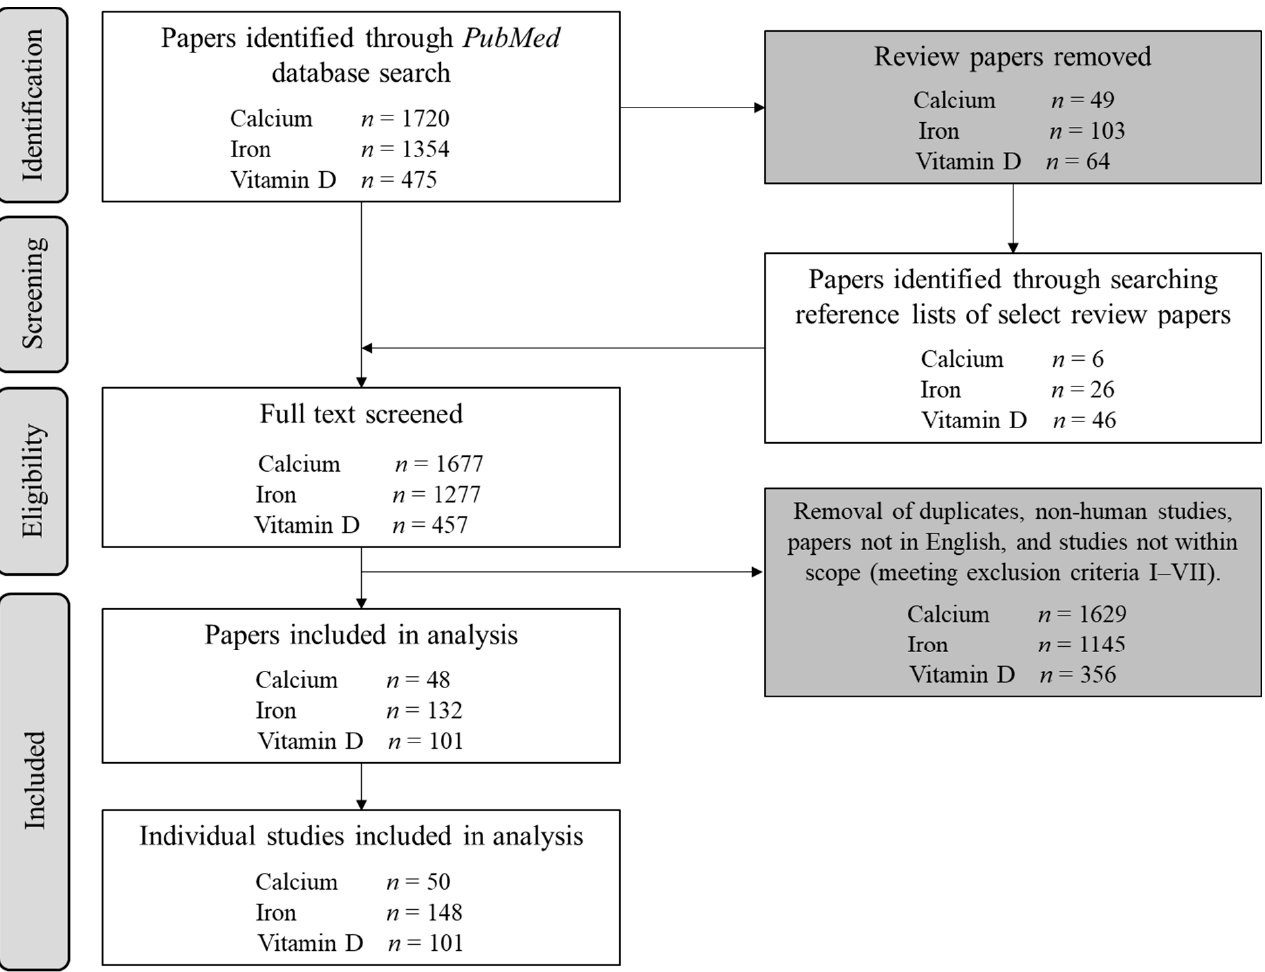
Figure 1. Flowchart illustrating the initial screening procedure for each supplement audited, along- side the total number of individual studies included for extraction of metrics A–F.